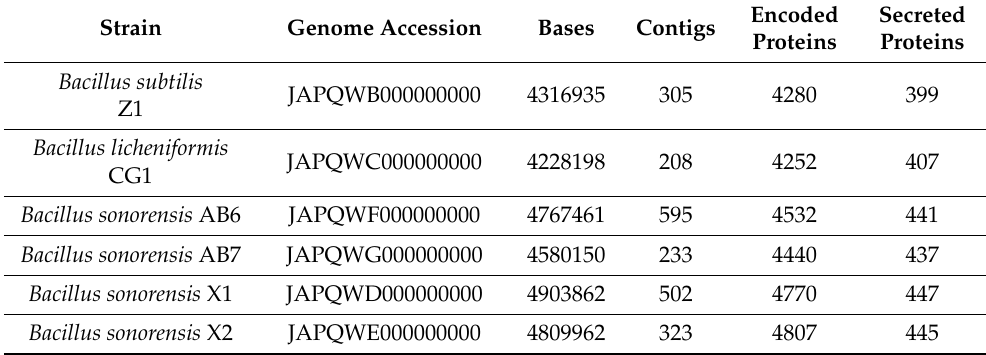
Table 2. Data obtained from the genomes of the six Bacillus strains isolated in this study.